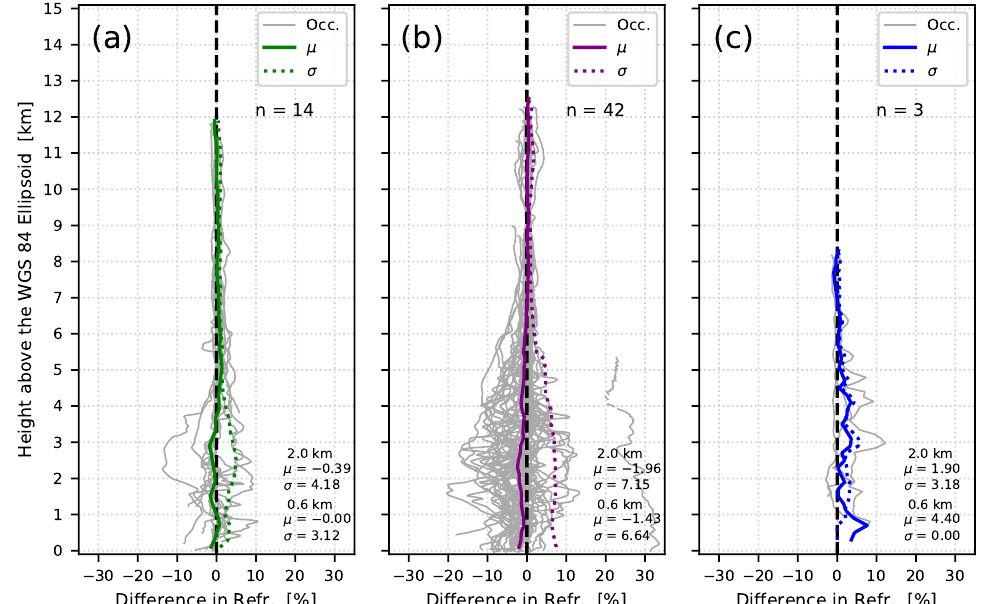
Figure 7. The percent difference (occultation minus dropsonde) in refractivity (% N) for pairs from the ( a ) operational, ( b ) COSMIC-2, and ( c ) Spire dataset where both observations were inside an AR and were within a distance threshold of 300 km and a time threshold of 2 h. Labels are the same as Figure 5.